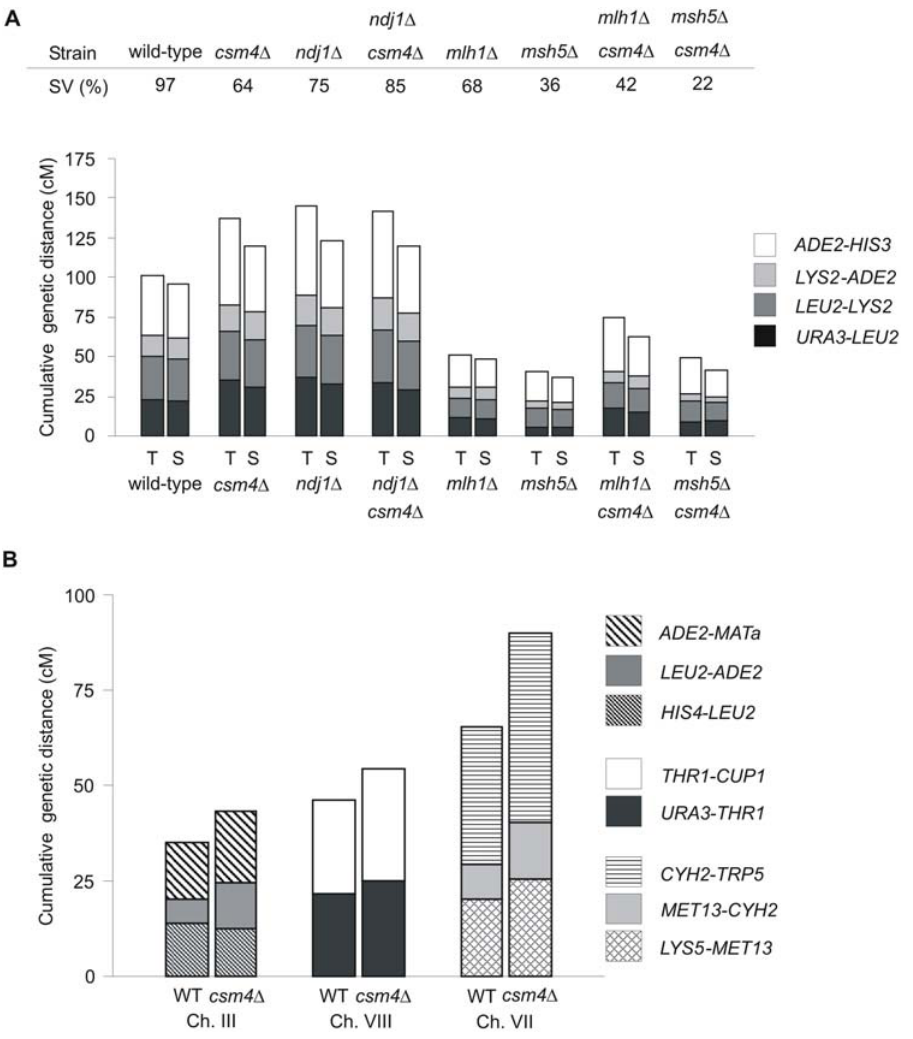
Figure 3. Cumulative genetic distance (cM) in WT, csm4 D , mlh1 D , msh5 D , and ndj1 D strains. In panels A and B, each bar is divided in sectors corresponding to genetic intervals in the region of the chromosome analyzed. A) Cumulative genetic distances between URA3 and HIS3 on chromosome XV in EAY1108/EAY1112 derived strains measured from tetrads (T) and single spores (S). B) Cumulative genetic distances between ADE2 and LEU2 on chromosome III, URA3 and CUP1 on chromosome VIII, and LYS5 and TRP5 on chromosome VII in the NH942/NH943 derived strains measured from tetrads (T) and single spores (S). See Tables 1 and S2 for raw data.